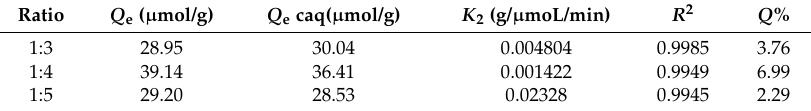
Table 3. Results of the Lagergren pseudo-second-order kinetic model.